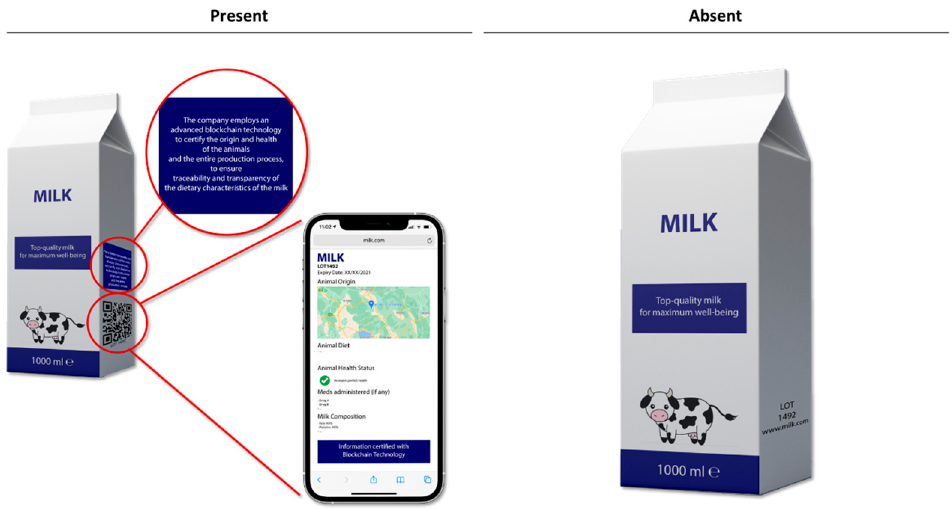
Figure 1. Mock-up product and conditions. Example UK Figure 1. Mock ‐ up product and conditions. Example UK version.